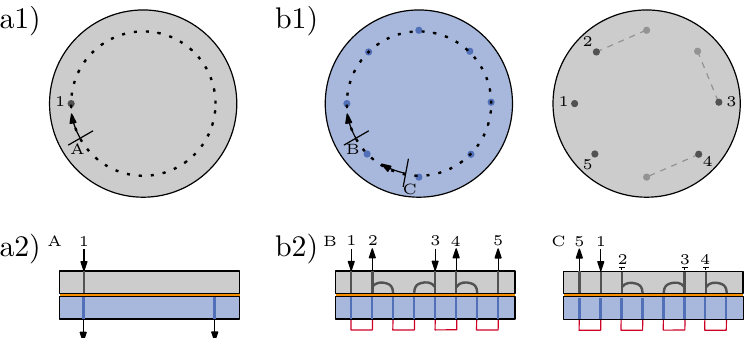
Figure 2. Schematic views of test setups. Stator is depicted in gray, rotor in blue. ( a1 ) Top view of stator and ( a2 ) circular sectional view of a test valve with one inlet and two outlet options. ( b1 ) Top view of rotor and stator of an upscaled valve; rotor features 8 inlet/outlet connections, stator features 5 with additional merging/diverging channels integrated into stator plate. ( b2 ) Circular sectional views of two connection schemes of upscaled valve. In both cases the inlet/outlet connections of rotor are short-circuited (no external connections). Left-hand side shows a case where all in- and outlets are used, and on the right-hand side, only one in- and outlet are